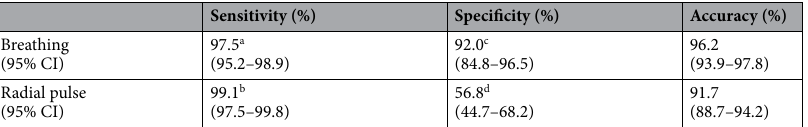
Table 3. Measures of sensitivity, specificity, and accuracy of breathing and radial pulse. a Proportion of times the participants accurately stated that breathing was 316 of 324. b Proportion of times the participants accurately stated that radial pulse was 347 of 379. c Proportion of times the participants accurately stated that no breathing was 92 of 100. d Proportion of times the participants accurately stated that no radial pulse was 42 of 45. CI confidence interval.